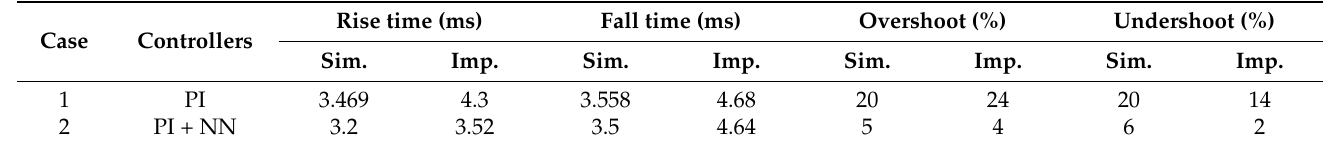
Table 6. Result Table 6. Result comparison.